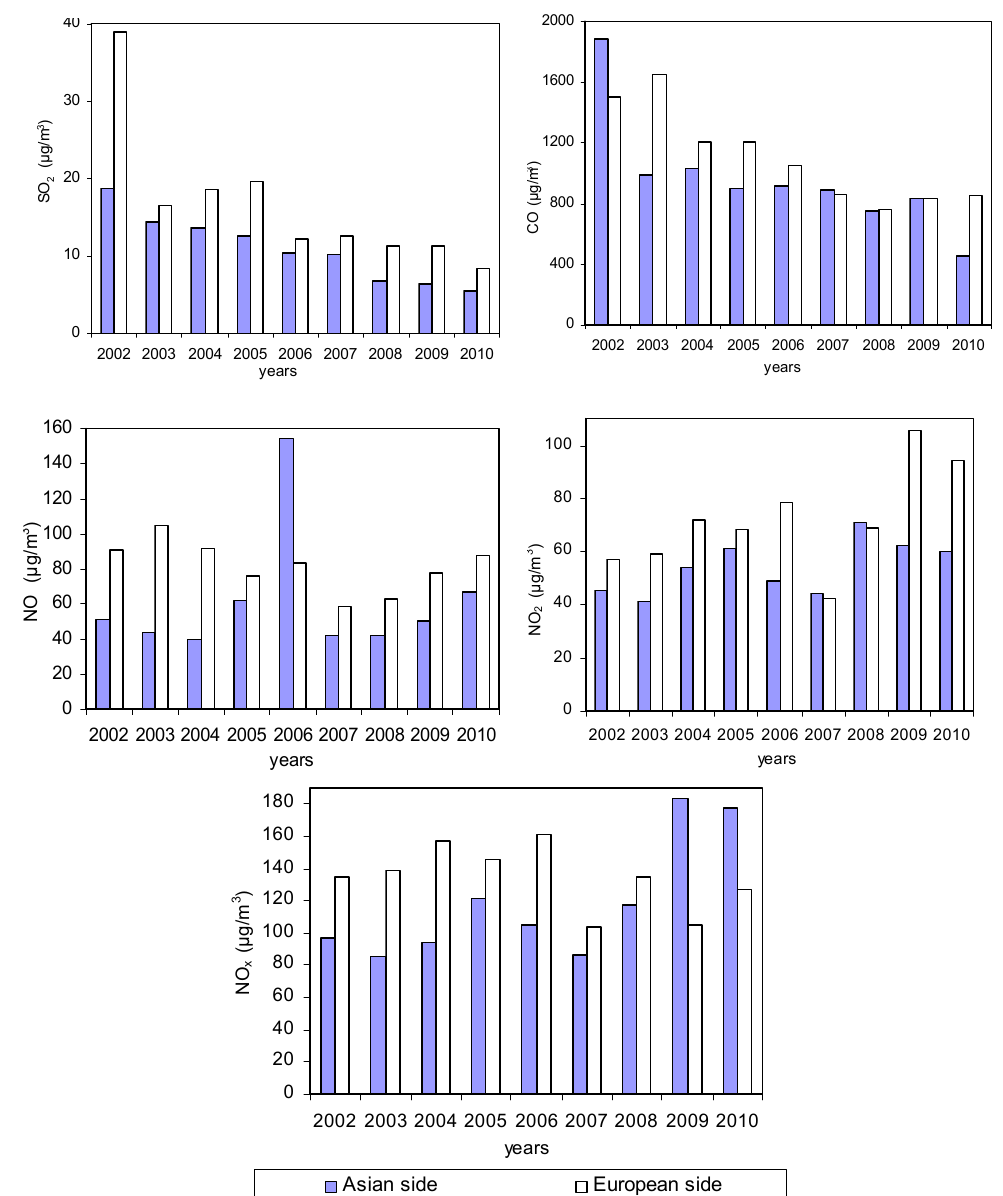
Figure 7. Yearly changes of air pollution parameters in Istanbul